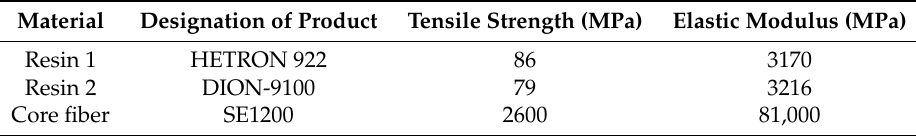
Table 1. Material properties of GFRP (glass fiber reinforced polymers)